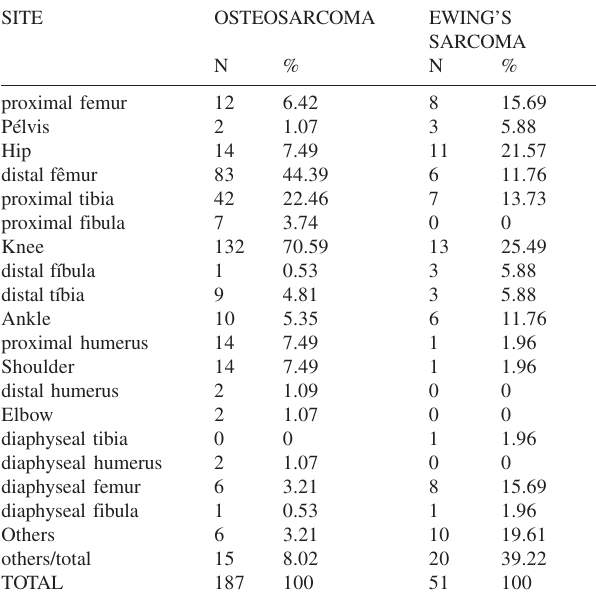
Table 2 - Absolute and relative frequency distribution (%) of sites affected by Osteosarcoma or Ewing’s Sarcoma in both groups, and intergroup comparison using a two-tailed chi-square test ( α =0.05) SITE OSTEOSARCOMA